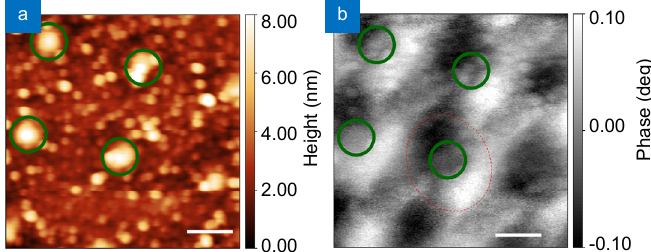
Fig. 3 | Correspondence between the laser-induced topographical relief (a) and MFM response (b) . The bumps on the Fe 60 Al 40 surface, occurring within Fig. 2 | MFM images of patterned structures that maxima of light intensity (solid contours), are significantly smaller in their lateral have different periodicities Λ of the interference dimensions than the regions in which the MFM response is nonzero. One of the pattern. ( a ) 0.4  m, ( b ), 0.6  m, and ( c ) 2.3  m. patterned magnetic entities is indicated by dashed